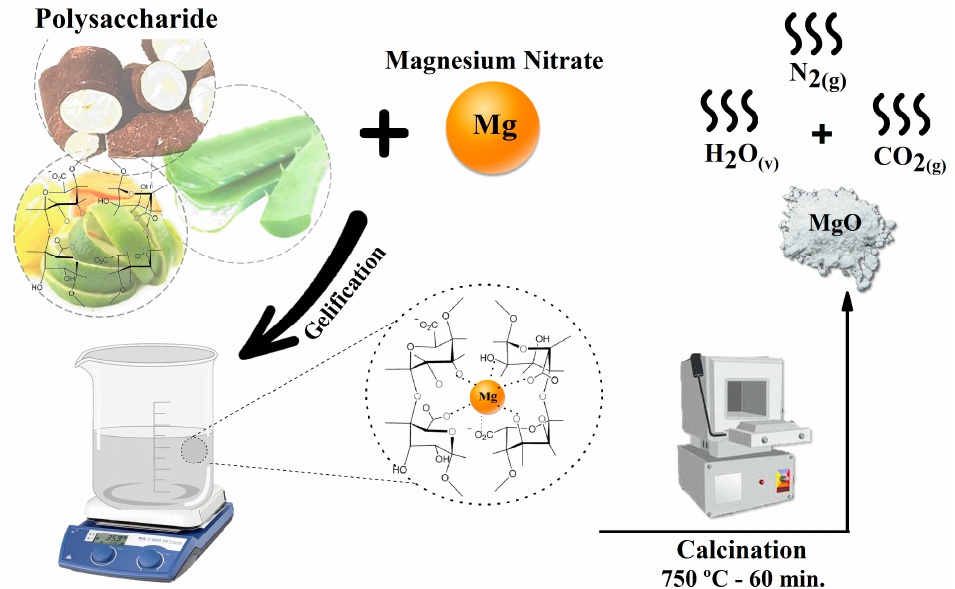
Figure 6. General schematic diagram of synthesis using polysaccharides as gelling complexing fuels.